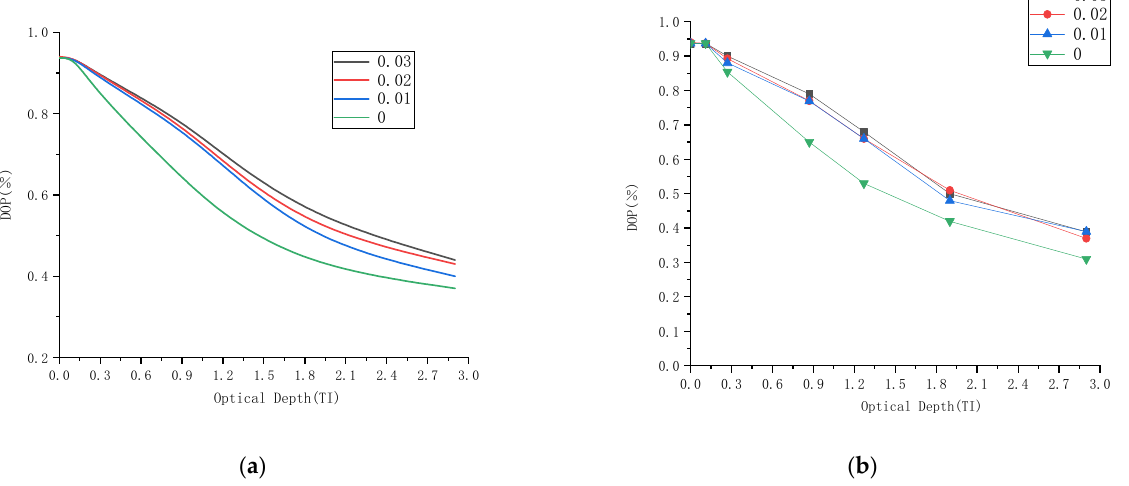
Figure 5. Simulation and experimental comparison of the relationship between salt content at 450 nm and DOP: ( a ) simulation results and ( b ) experimental results.